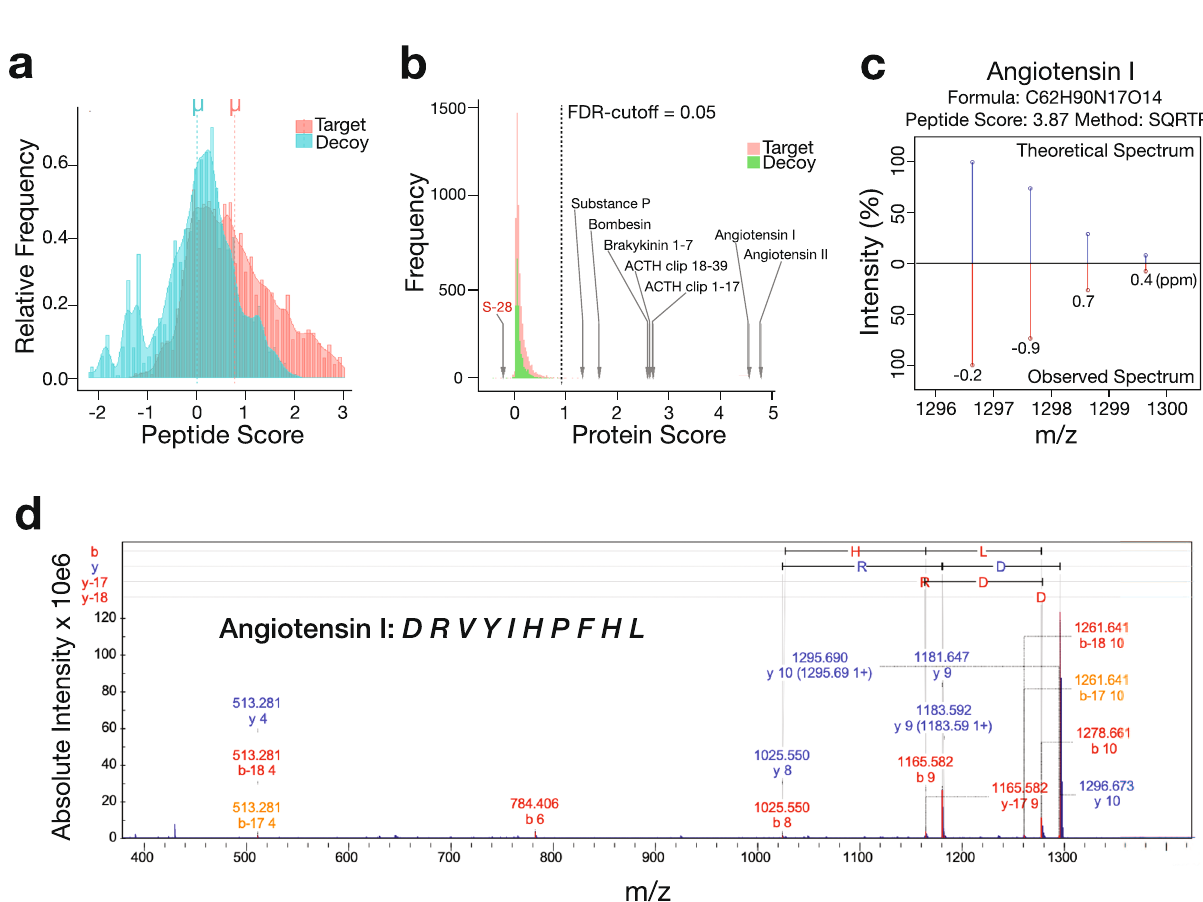
Fig. 3 Benchmarking of HIT-MAP against the Bruker Peptide Calibrant II. The frequency distribution of a peptide and b protein target-decoy candidate list scores demonstrates the robust separation of our false-discovery rate (FDR) system accurately identifying 7/8 peptides. c Example of the HIT-MAP predicted and actual peptide mass fi ngerprint analysis of angiotensin I from the Bruker Peptide Calibrant. d Tandem MS/MS validation of angiotensin I identi fi cation in Bruker Peptide Calibrant spot. ppm = parts per